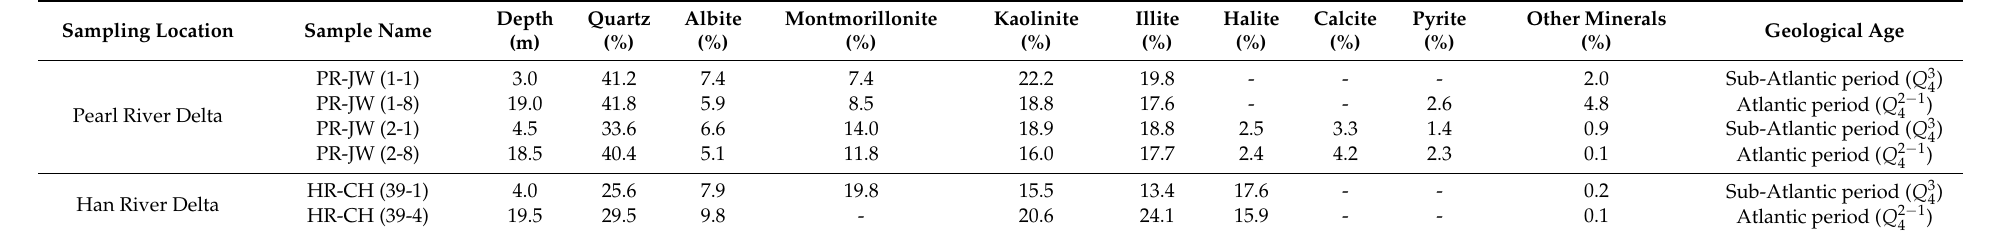
Table 3. The mass ratio of sedimentary minerals composition in marine clay of the Pearl River Delta in the Jinwan (JW) District of Zhuhai [53] and the Han River Delta in the Chenghai (CH) District of Shantou